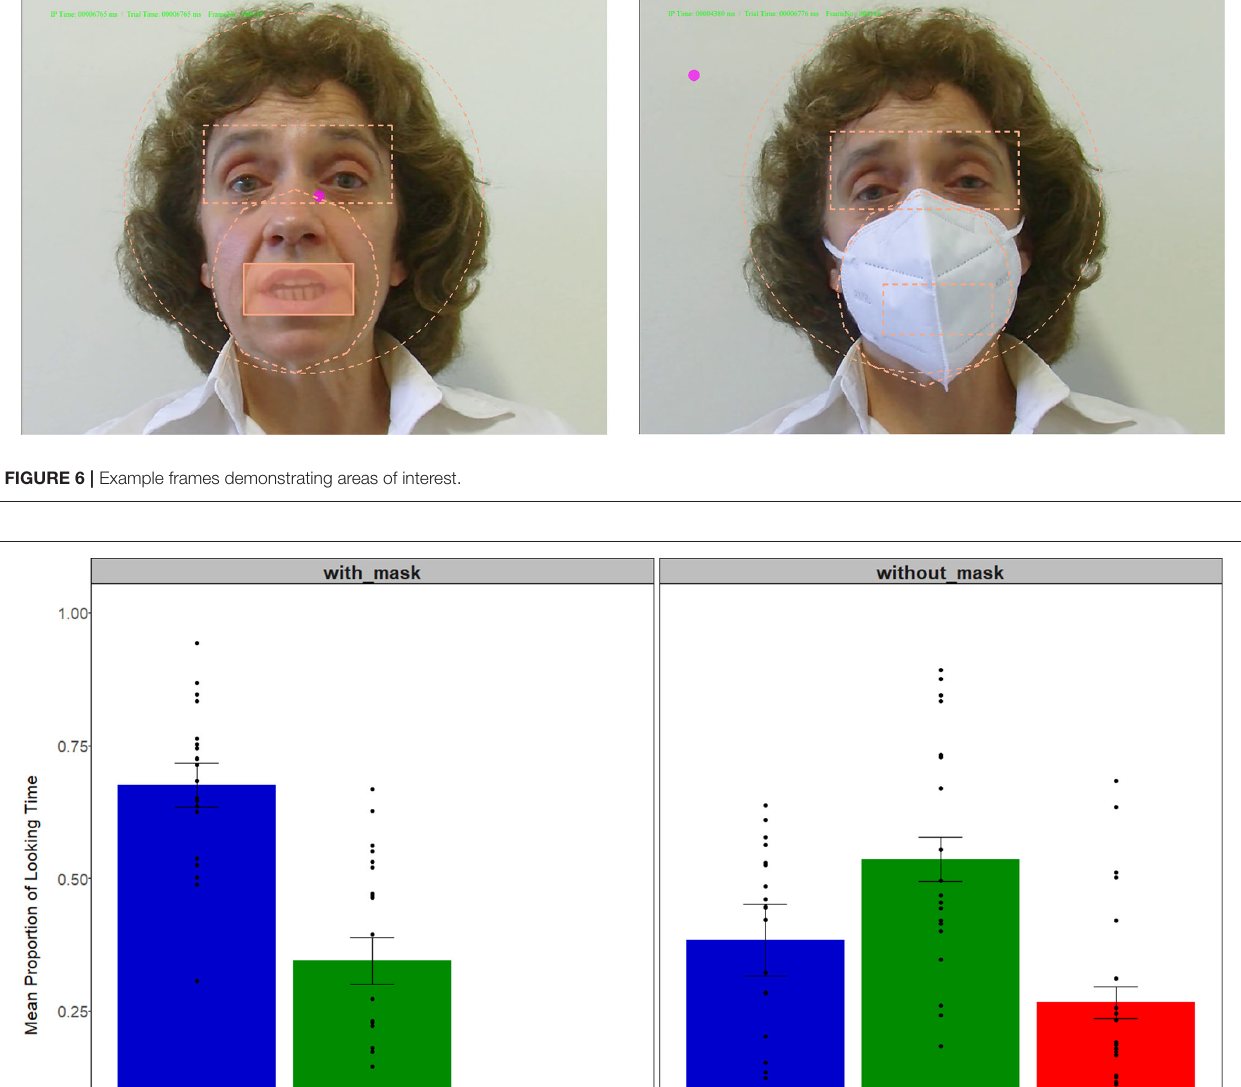
Specifically, the infants attended more to the screen during the test trials when previously familiarized with videos without the mask (M = 6.9), in comparison to being familiarized with videos with the mask (M = 5.7). No other effect reached significance [ F s < 0.4, p s >